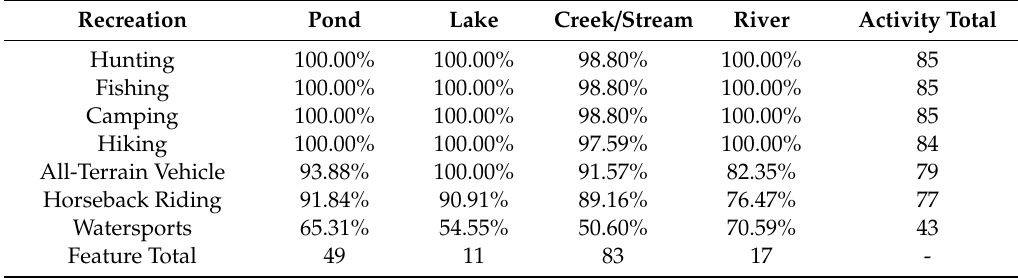
Table 3. Cross-tabulation of recreational activities by hydrological features based on 86 working forest conservation easements in